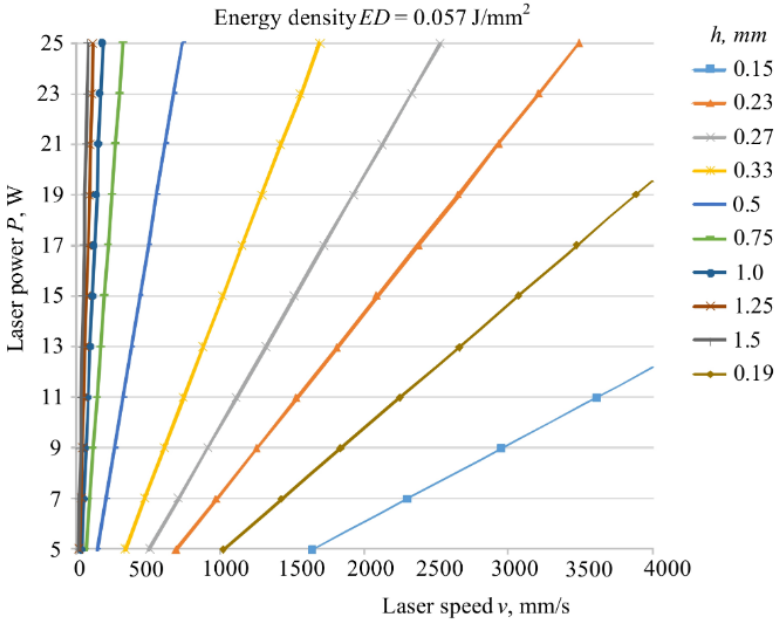
Figure 20. Diagram for selection of SLS process parameters [151].